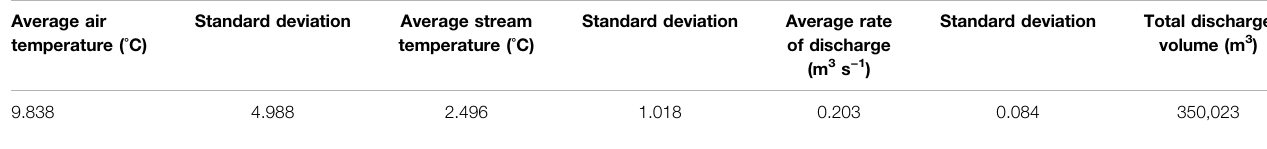
TABLE 4 | Wells Creek discharge data from August 17, 2020 through September 5, 2020, shared by the Nooksack Indian Tribe in the interest of scienti fi c collaboration. Average air temperature ( °